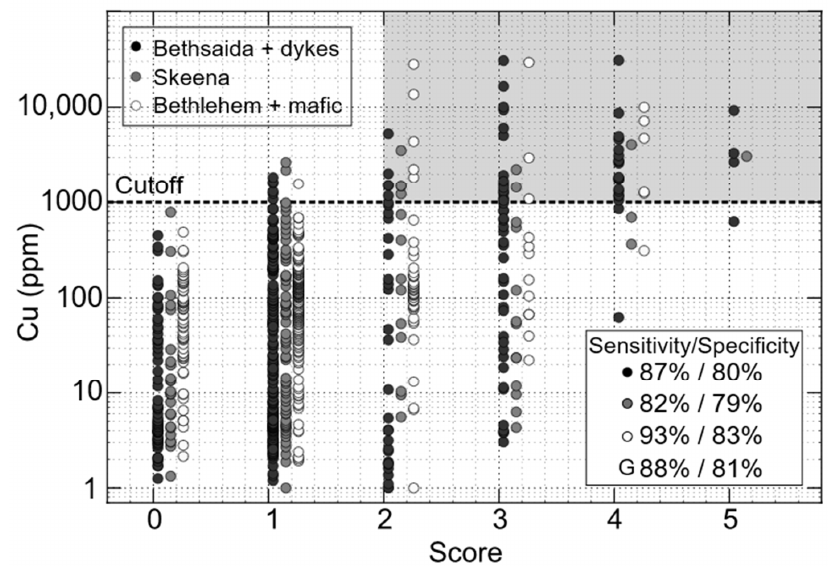
Figure 8. Correlation between the Cu concentration and the spectral alteration score obtained for the 755 slabs using the common mineralogical parameters. Samples scoring 2 or above are considered mineralized ( > 1000 ppm Cu). Classification results (sensitivity / specificity) are listed in the lower right for each rock group, as well as for the entirety of the dataset (G). Mineralogical data and spectral score derived for the 755 rock slabs is provided in supplementary Table